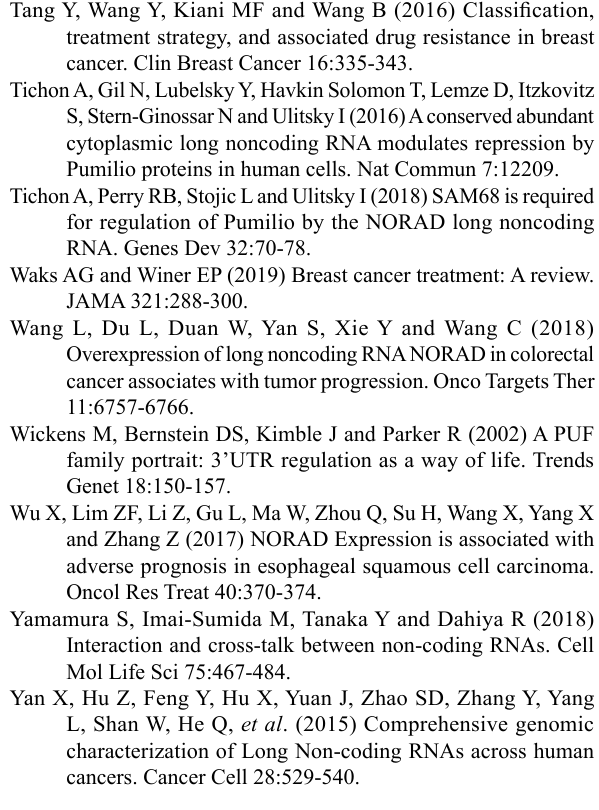
Figure S1 – CLUSTAL sequence alignment of NORAD and HCG11. Figure S2 – Kaplan-Meier plots representing TCGA BRCA entire cohort stratified by NORAD and HCG11 median